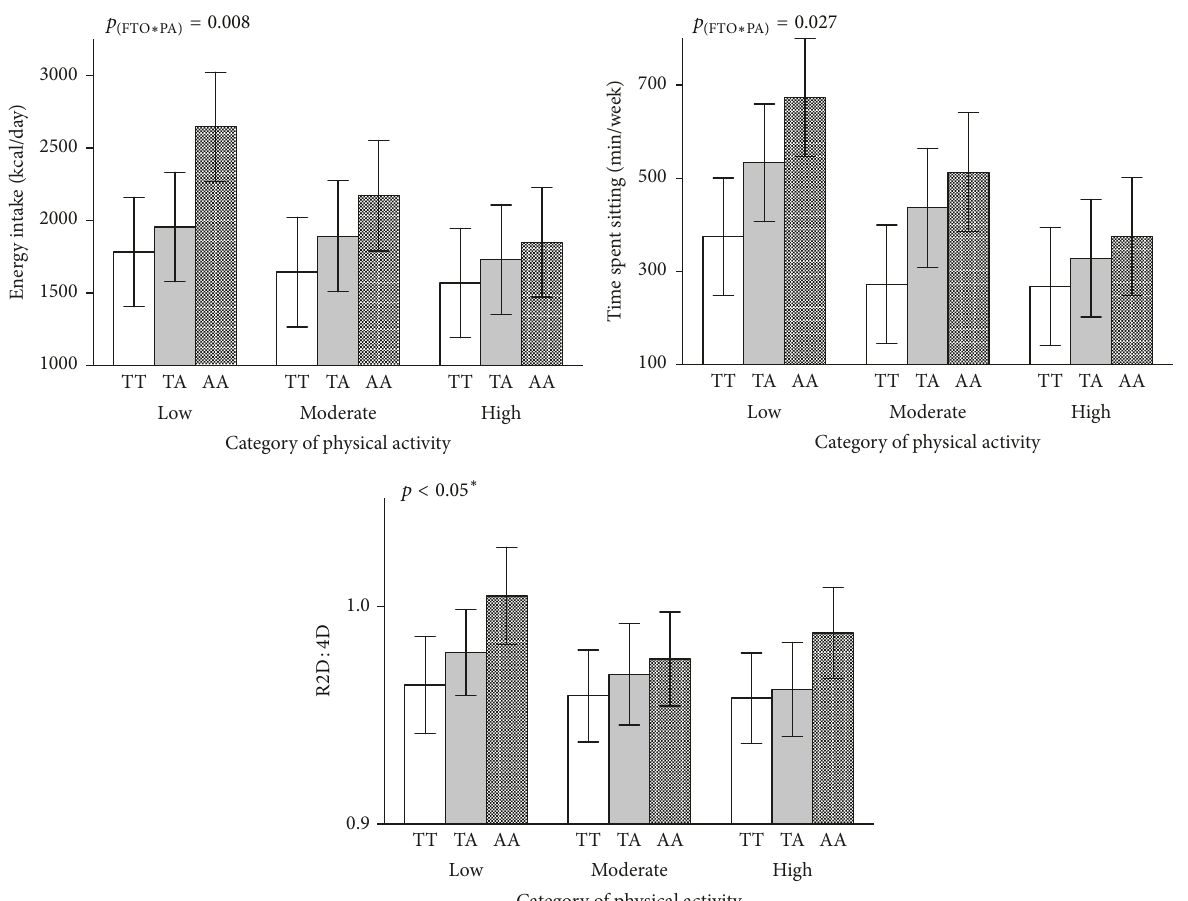
Figure 4: Effect of the FTO rs9939609 genotype on energy intake, TSS, and R2D :4D stratified by category of PA. 𝑝 values are for the interaction between the FTO variant and PA category; least-squares means of different genotypes across all PA groups were calculated by using Robust Linear Regression analysis, with adjustment for age and sex. Allele frequency by PA category was low: 20/43/14; moderate: 28/34/13; high: 27/13/9 for TT, TA, and AA genotypes, respectively. TSS: time spent sitting. R2D :4D; ratio of the left hand second digit to the fourth, and TSS; time spent sitting. ∗ Mean of each variable with genotype for high PA is different from mean of each genotype for low PA at 𝑝 < 0.05 but not in R2D: 4D TT and AA